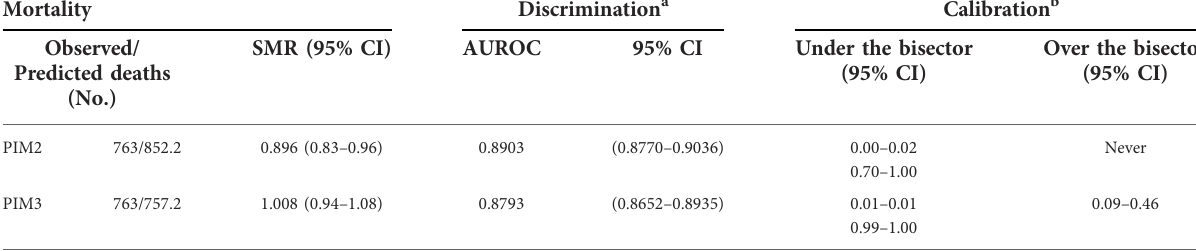
TABLE 3 Comparison between the performance of PIM2 and PIM3 in the study population. Mortality Discrimination a Observed/ Predicted deaths (No.)